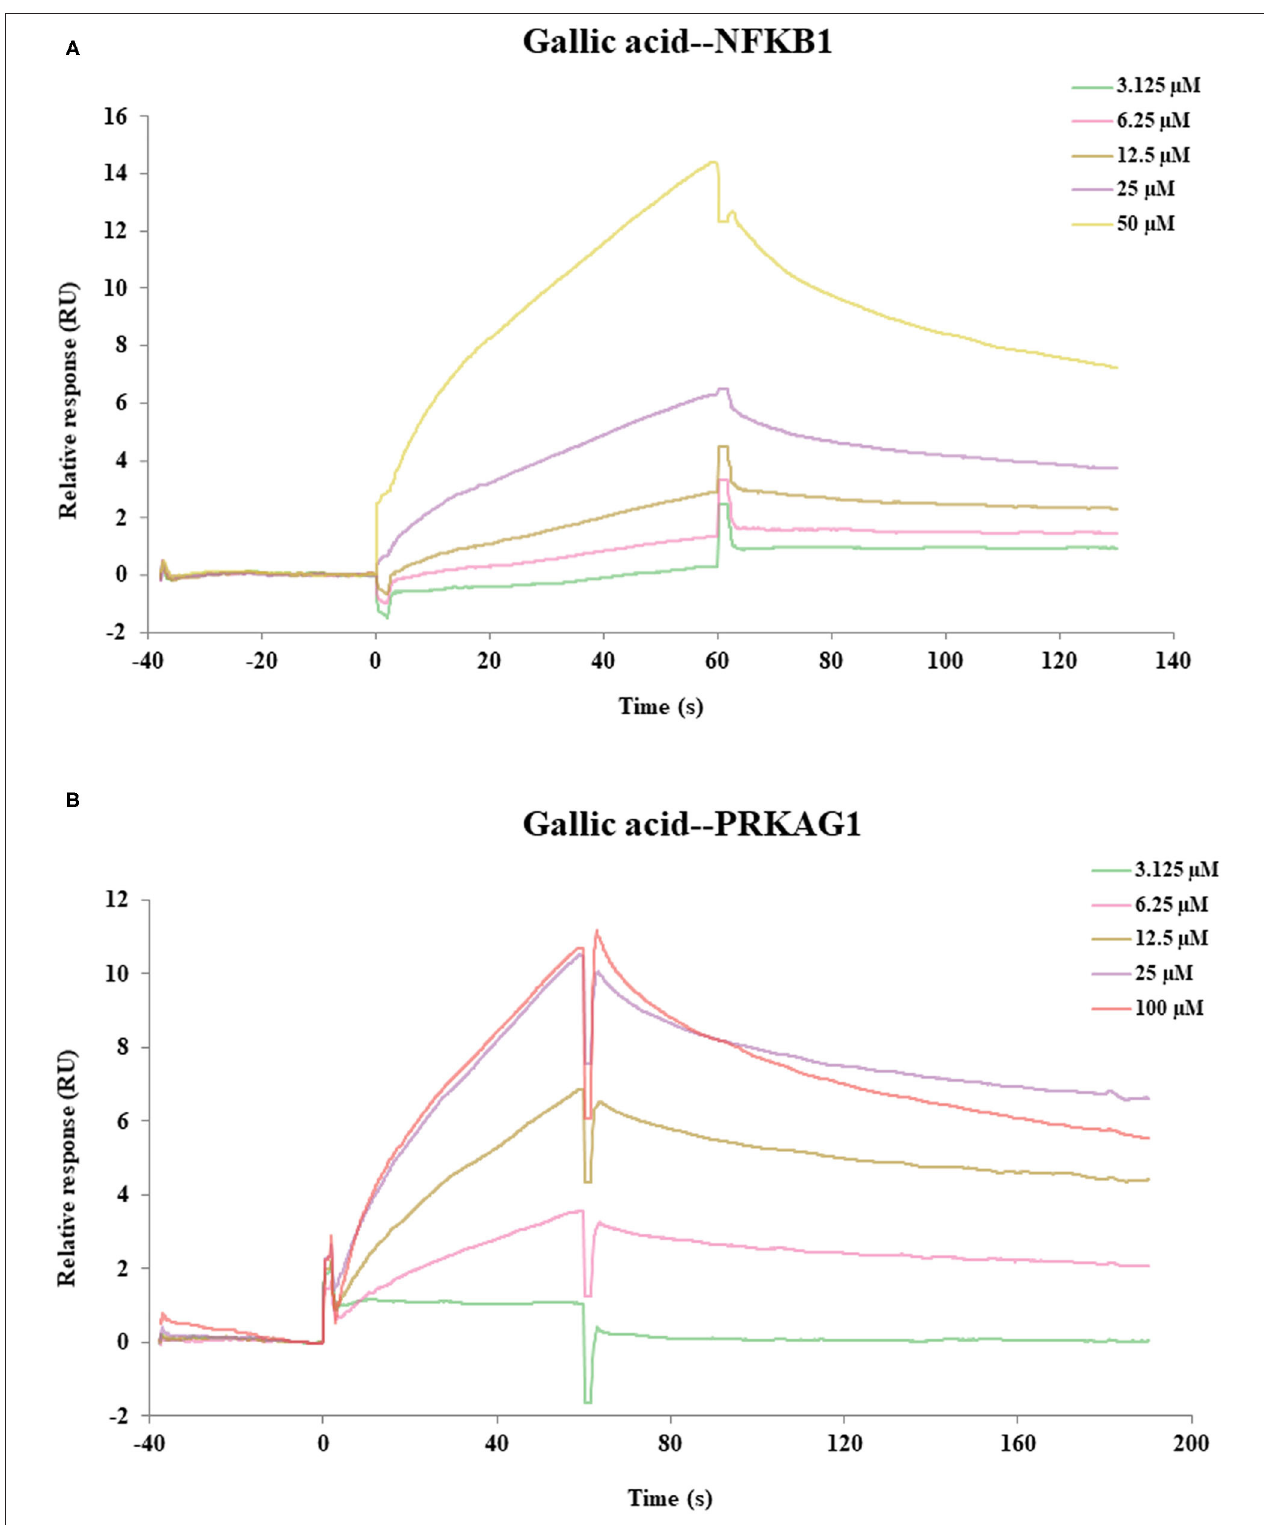
FIGURE 6 | The SPR assay of the interaction of gallic acid with NFKB1, gallic acid with PRKAG1. (A) The SPR curves of gallic acid binding to NFKB1. (B) The SPR curves of gallic acid binding to PRKAG1.